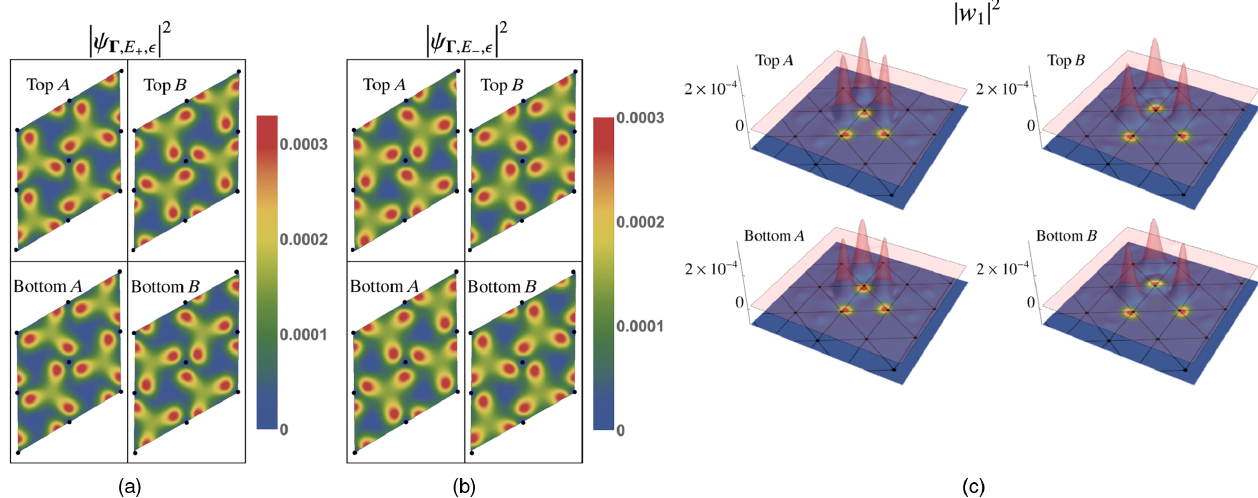
j 2 and j ψ j 2 and (c) the localization of the WSs obtained Γ ;E − ; ϵ ;E þ ; ϵ